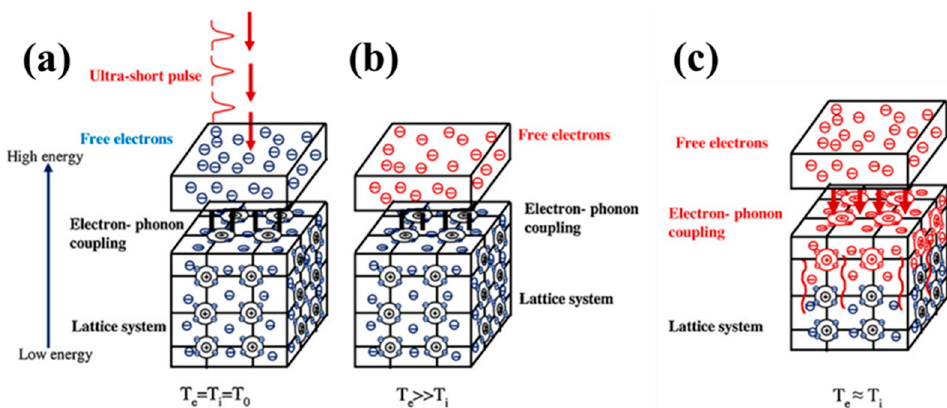
Figure 1. Mechanism of interaction between ultrashort pulse laser and materials (Te-electron tem- perature, T i -lattice temperature, T 0 -ambient temperature). ( a ) absorption. ( b ) Heating. ( c ) Energy transfer [19].